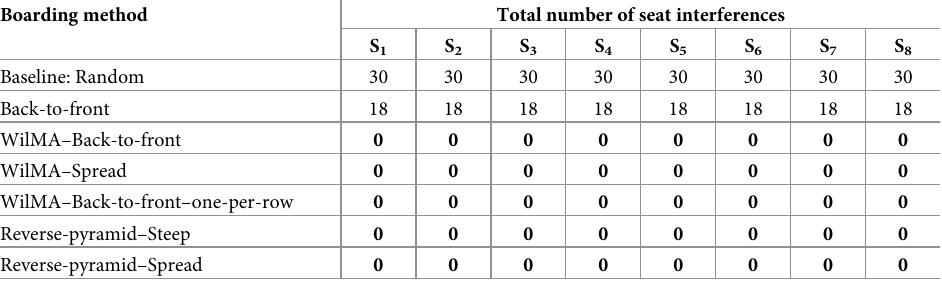
Table 5. Total number of seat interferences.